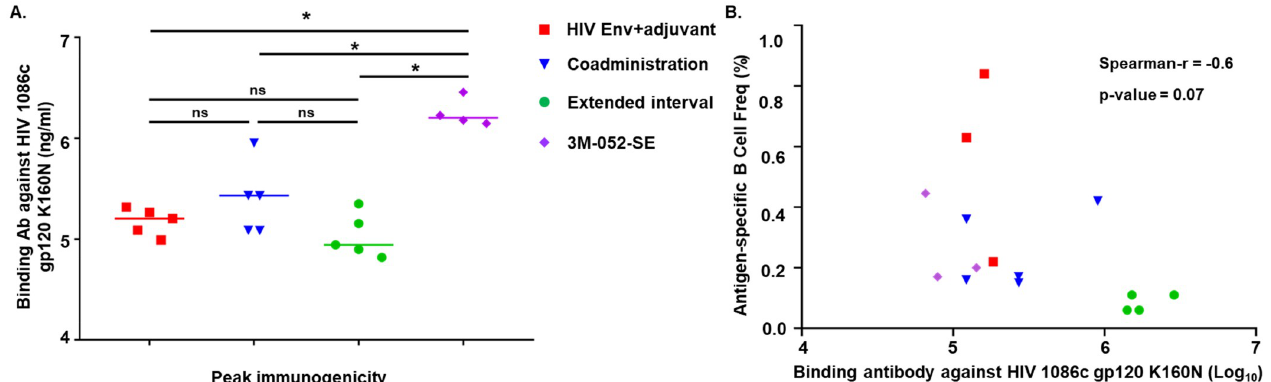
Fig 2. Vaccine-induced Env binding IgG responses against HIV 1086c gp120 K160N does not correlate with frequency of antigen-specific memory B cells in infants. (A) Binding antibody level was significantly higher in the 3M-052-SE group as measured by ELISA at peak immunogenicity. (B) Binding antibody levels at peak immunogenicity was not correlated with antigen-specific memory B cell frequencies in all vaccine groups. Statistical analyses were performed with GraphPad Prism, � denoted significant p-values of < 0.05 by a non-parametric Mann-Whitney test. Correlation analysis was performed using Spearman’s rank correlation test with GraphPad Prism, with p-value of < 0.05 considered as